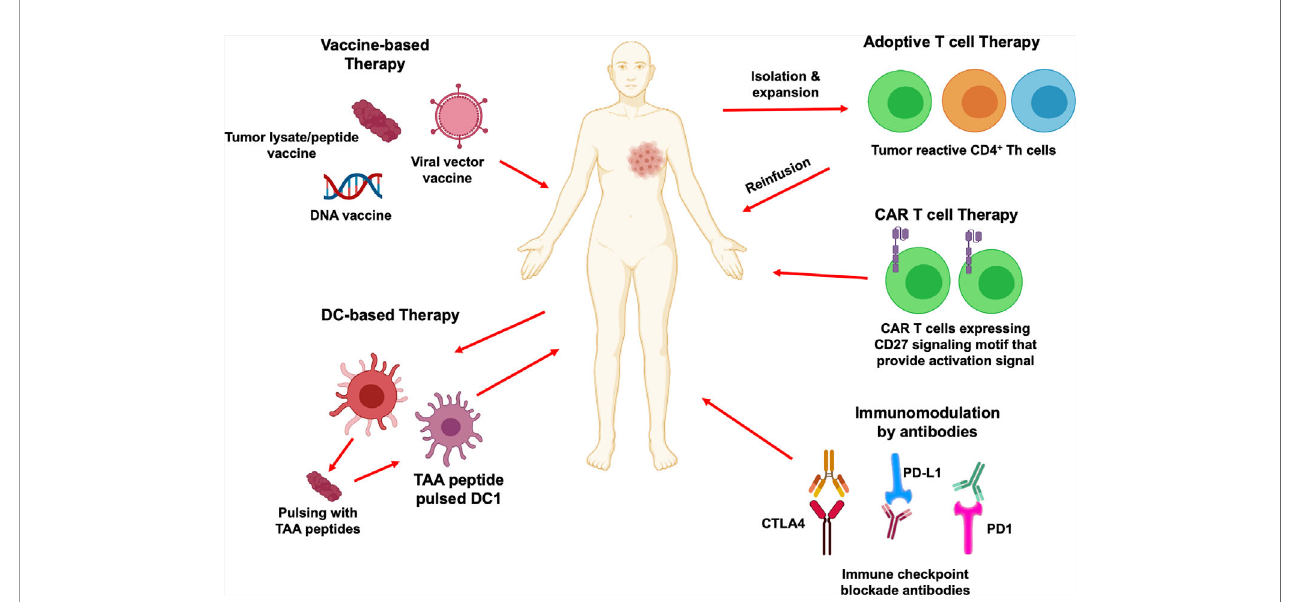
FIGURE 4 | CD4 + T cells in cancer immunotherapy. Immunotherapeutic strategies that activate CD4 + T cells and their downstream effector immune cells for cancer treatment are depicted. Therapeutic vaccination includes tumor antigenic peptides, viral vector-based vaccine and DNA based vaccine that can mediate CD4 + T cells immune responses. DC-based vaccines can prime CD4 + T cells and create signals to activate cytotoxic CD8 + T cells differentiation and anti-tumor function. Adoptive transfer of tumor speci fi c CD4 + T cells is another attractive immunotherapy approach which helps to develop speci fi c and strong anti-tumor immune reaction. Chimeric antigen receptors can also redirect CD4 + T cells and provide activation signals to recognize cancer cells to eliminate them. Blockade of immune checkpoints PD1, PD-L1 and CTLA4 by antibodies can prevent tumor associated immunosuppressive environment and enhance tumor speci fi c CD4 + and CD8 + T cells immune